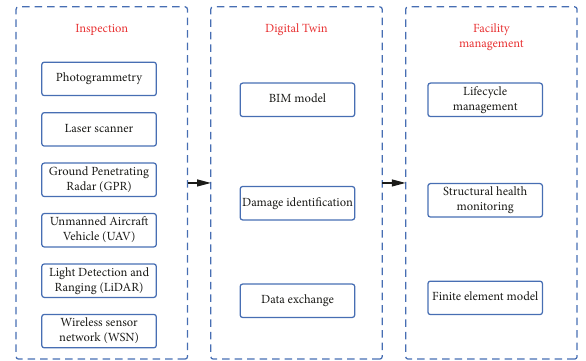
Figure 8: Bridge facilities management framework based on digital twins.